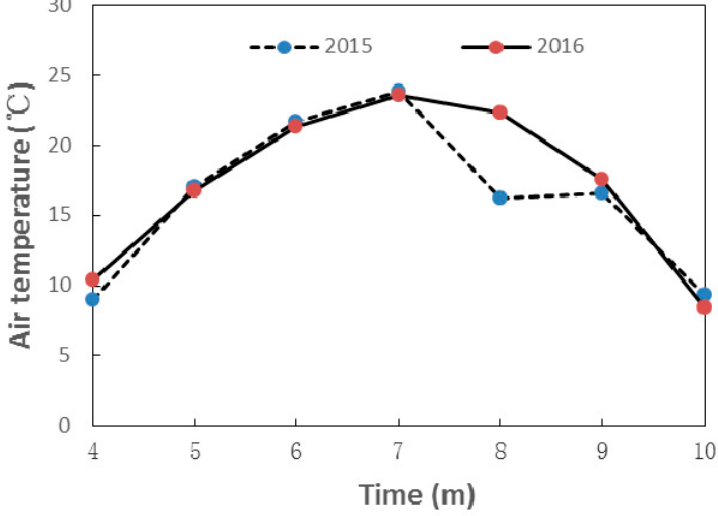
Figure A2. Air temperature (curve) of the experimental site in 2015 and 2016.